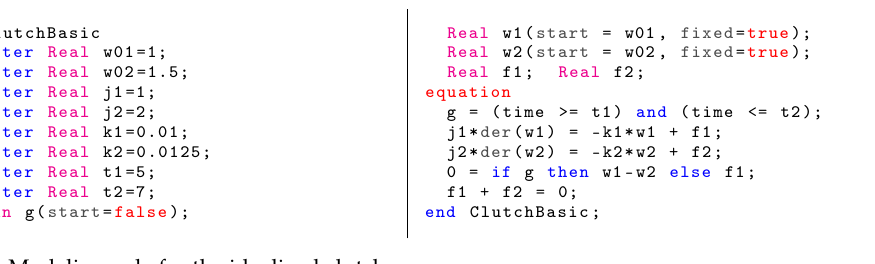
Figure 9. Modelica code for the idealized clutch.